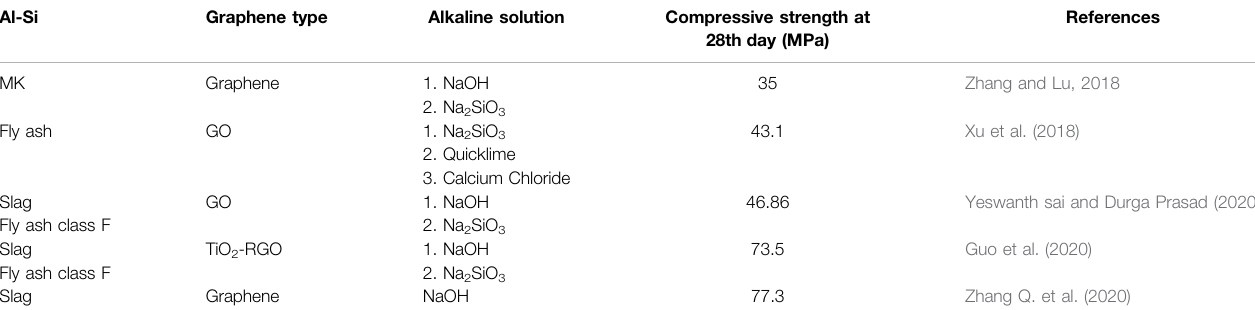
TABLE 3 | Summary of compressive strength for Graphene Reinforced Geopolymer Nanocomposites. Al-Si